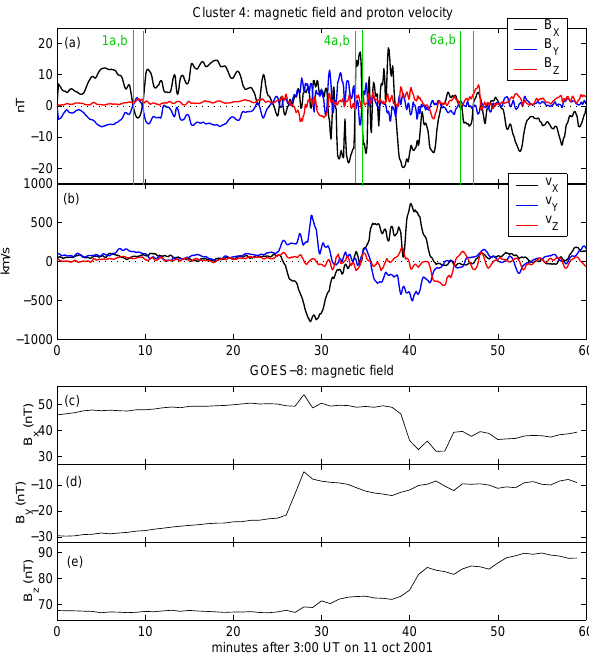
Fig. 3. Upper part: the components of magnetic field and proton ve- locity measured by Cluster 4, 03:00–04:00 UT on 11 October 2001, in GSM coordinates; magnetic field from FGM and proton veloc- ity from CIS-CODIF. Lower part: the magnetic field components measured by Goes-8 during the same